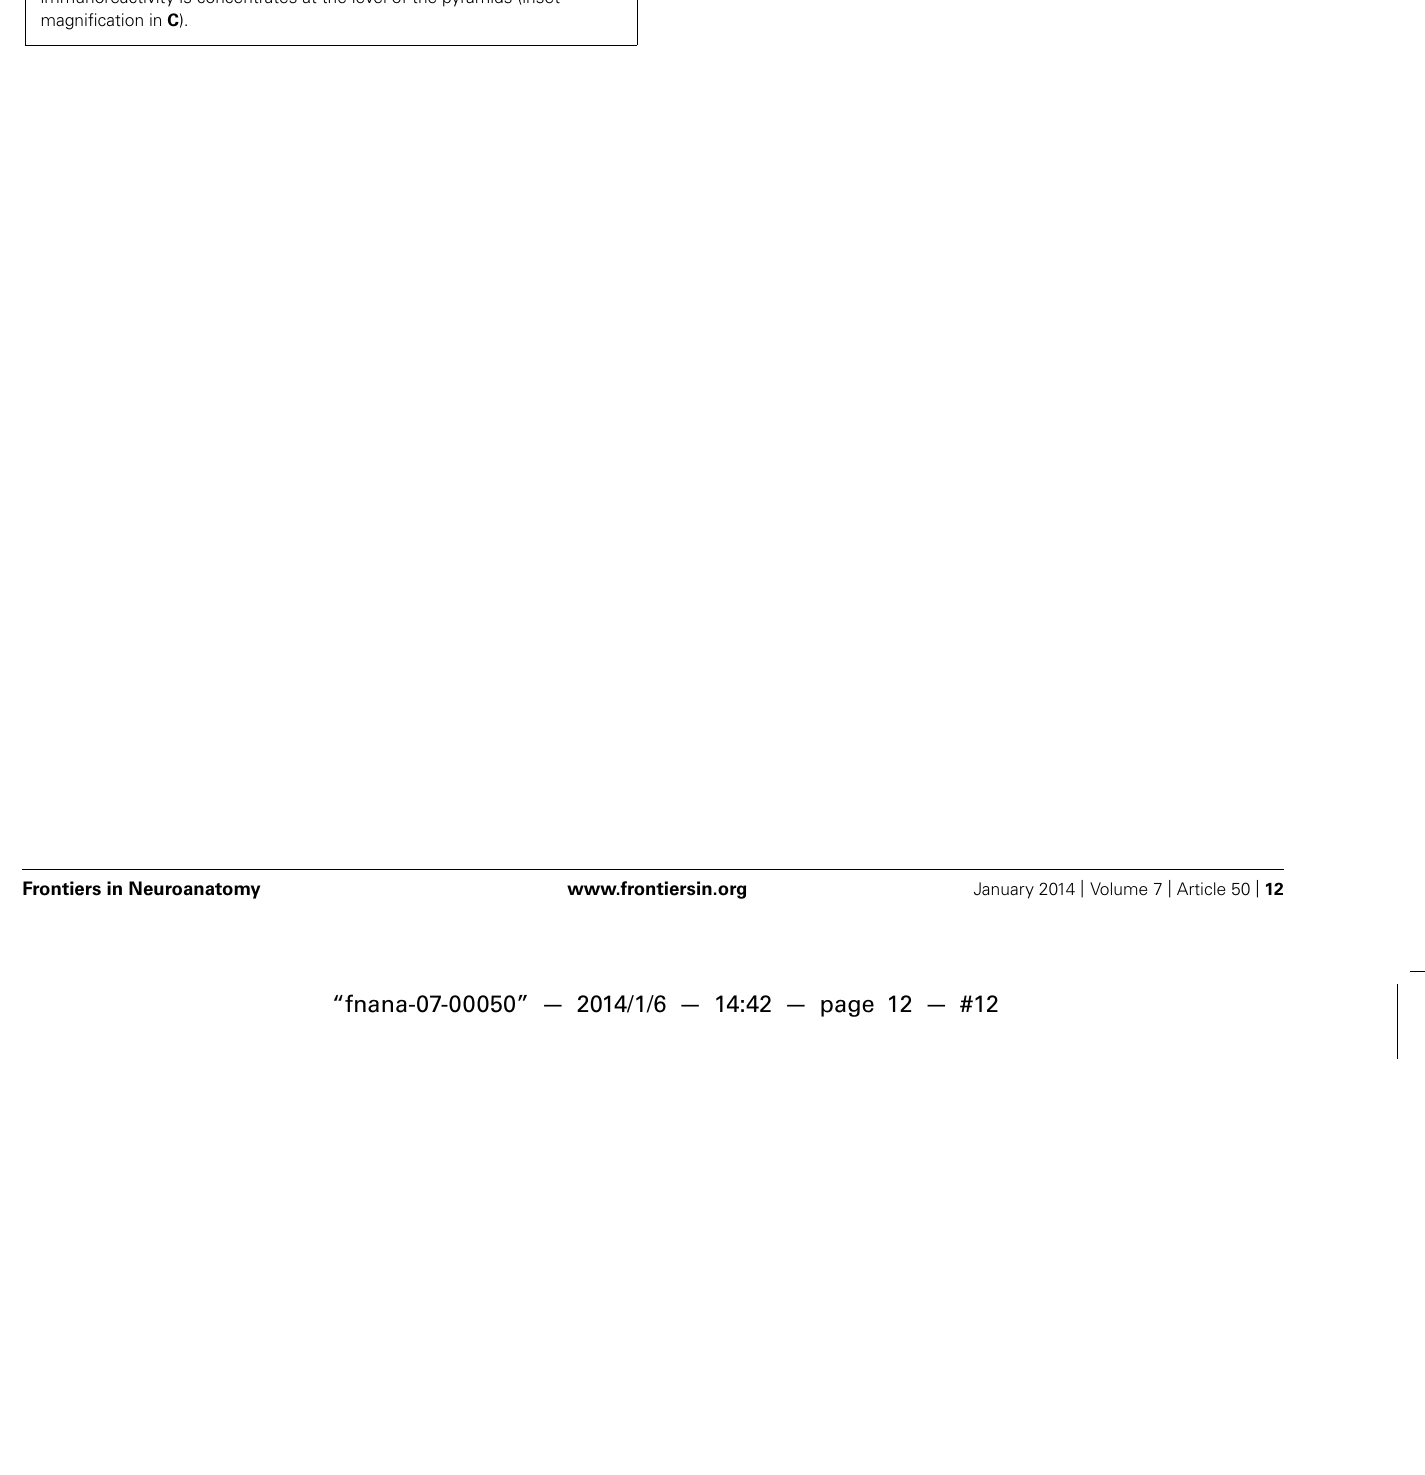
FIGUREA2 |At low resolution, EGFP-VAMP2 (Maiuscolo) signal is detectable in fiber-rich, cell-body-poor territories. (A) Left : LacZ staining of a frontal adult Emx1-Cre Rosa26 LacZ / + mouse forebrain hemisection reveals location of cell bodies (reproduced with permission from Gorski etal., 2002); right : similar section from an Emx1-Cre Rosa26 EGFP − VAMP 2 / + brain immunostained for EGFP reveals complementary distribution of the reporter, which is enriched in cell-poor regions. (B) Likewise, in a medulla oblongata hemisection, EGFP immunoreactivity is concentrates at the level of the pyramids (inset magnification in C ).